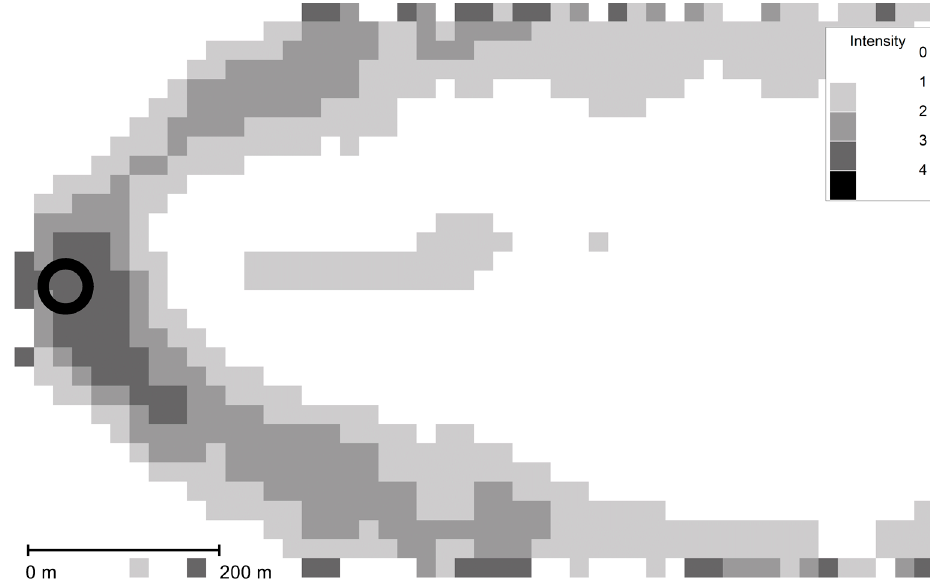
Figure 2. Modeled intensities of concentration fluctuations using Equation (48) near a point source indicated by the circle, and a wind direction from the left.